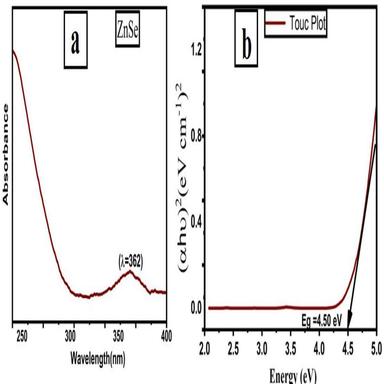
(a) Absorption spectrum & (b) Corresponding Tauc's Plot of ZnSe NRs.